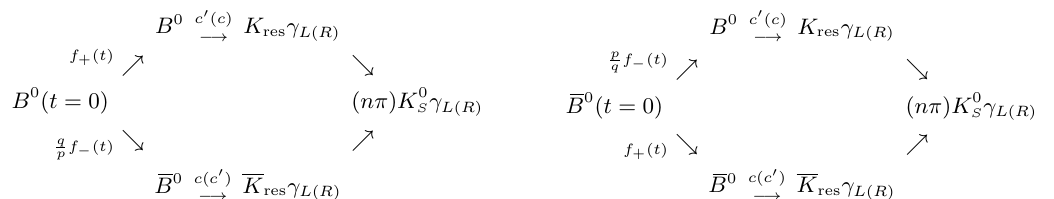
Figure 1 . Schematic description of the time-dependent CP asymmetry of B ! K res (cid:13) ! ( n(cid:25) ) K 0 The factors f (cid:0) ( t ) and f + ( t ) are the time-dependent oscillation and non-oscillation probabilities, respectively, of a B 0 or a B 0 meson. The q and p are the B (cid:0) B oscillation parameters, which correspond to q=p ’ ( V (cid:3) V td ) = ( V tb V (cid:3) ) = e (cid:0) 2 i(cid:12) in the SM. The coe(cid:14)cients c and c 0 represent the tb td ratio of the standard operator contribution s(cid:27) (cid:22)(cid:23) (1 + (cid:13) 5 ) bF (cid:22)(cid:23) and that of the non-standard one s(cid:27) (cid:22)(cid:23) (1 (cid:0) (cid:13) 5 ) bF (cid:22)(cid:23) , respectively. In the SM, c 0 =c ’ m s =m b ( ’ 0) leading to an expected CP asym- metry to be almost